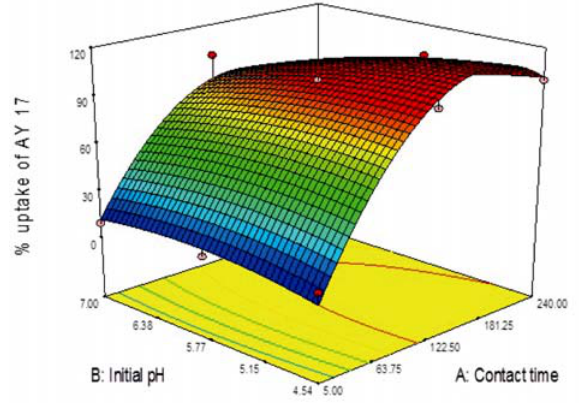
Figure 17. 3D surface plot of AY 17 as a function of initial pH and contact